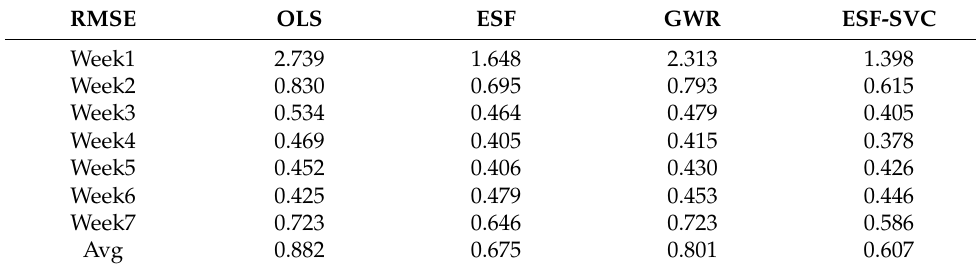
Table 5. RMSE of cross validation result (LOOCV) in Hubei province.